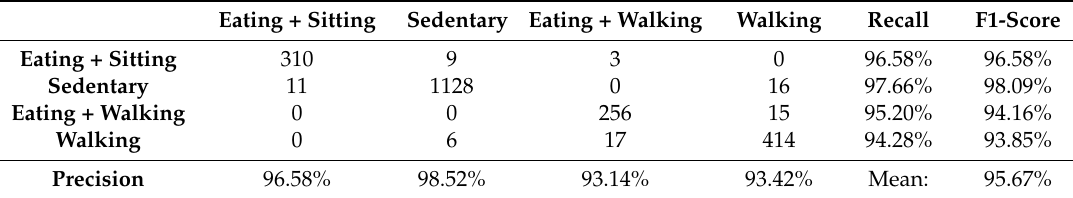
Table 3. Confusion Matrix for single multiclass linear SVM classifier. Precision, Recall, and F1-score are also listed for each class of